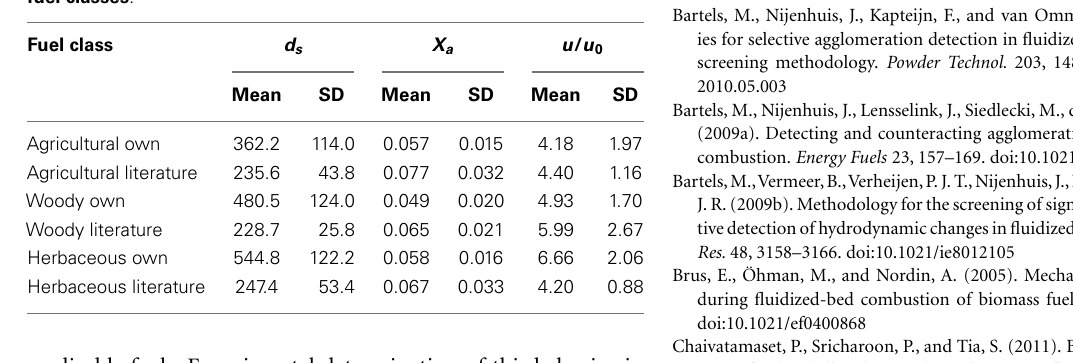
Table 7 | Comparison of average operational parameters for different fuel classes